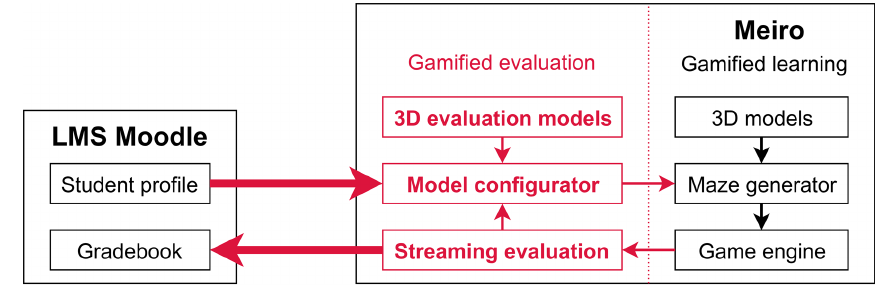
Figure 3. Extending Meiro to support gamified evaluation.